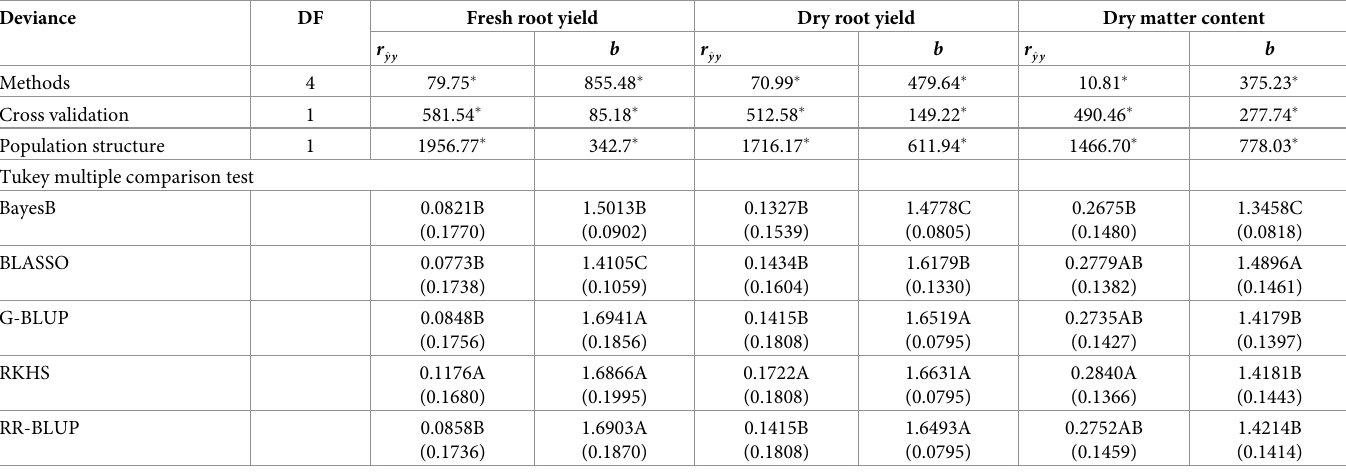
Table 3. LRT analysis and Tukey’s pairwise test (p � 0.05) for genomic selection prediction considering the 2 nd , 3 rd , and 4 th cross-validation strategies to estimate the effect of population structure for fresh root yield, dry root yield and dry matter